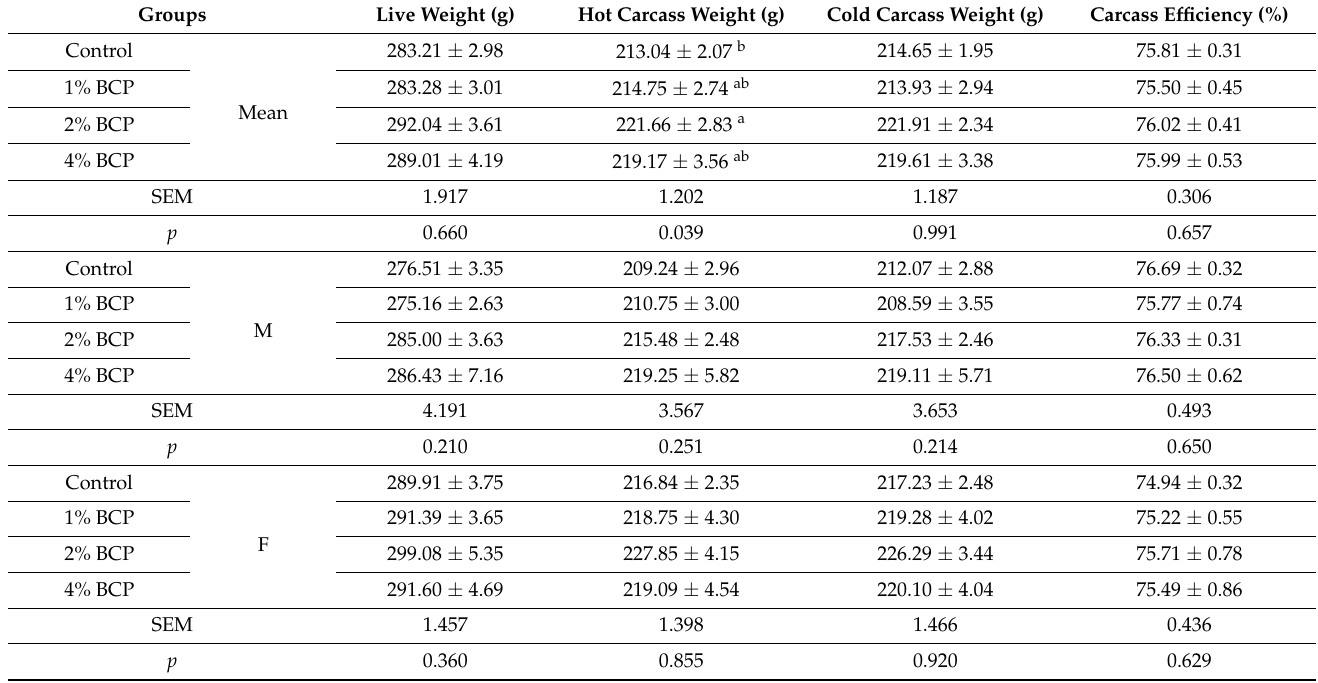
Table 3. The effect of BCP supplementation at different levels on the carcass